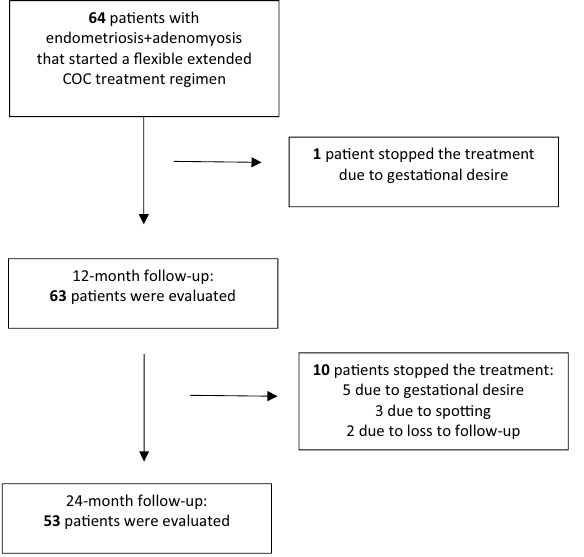
Figure 1. Flow chart of patient inclusion and drop-out.